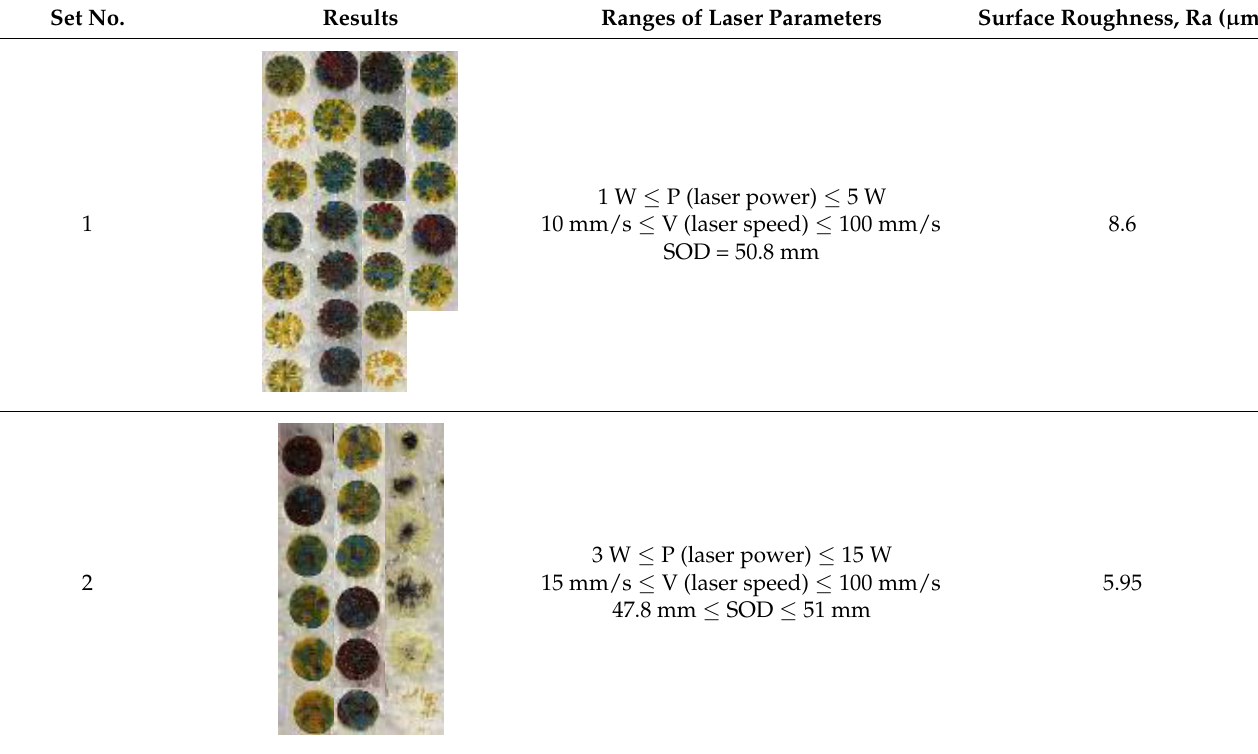
Table 3. Preliminary results concerning different laser parameters and surface roughness values.